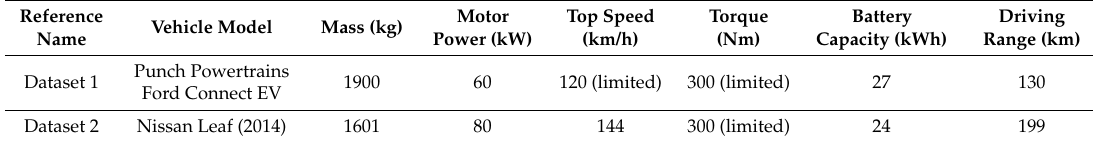
Table 1. Overview of the vehicle specifications of both vehicle models in the two datasets. EV: electric